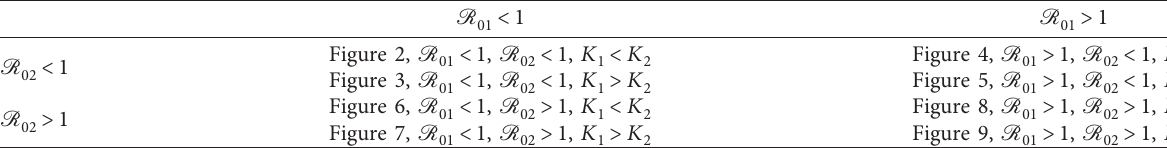
Figure 7, R Figure 9, R